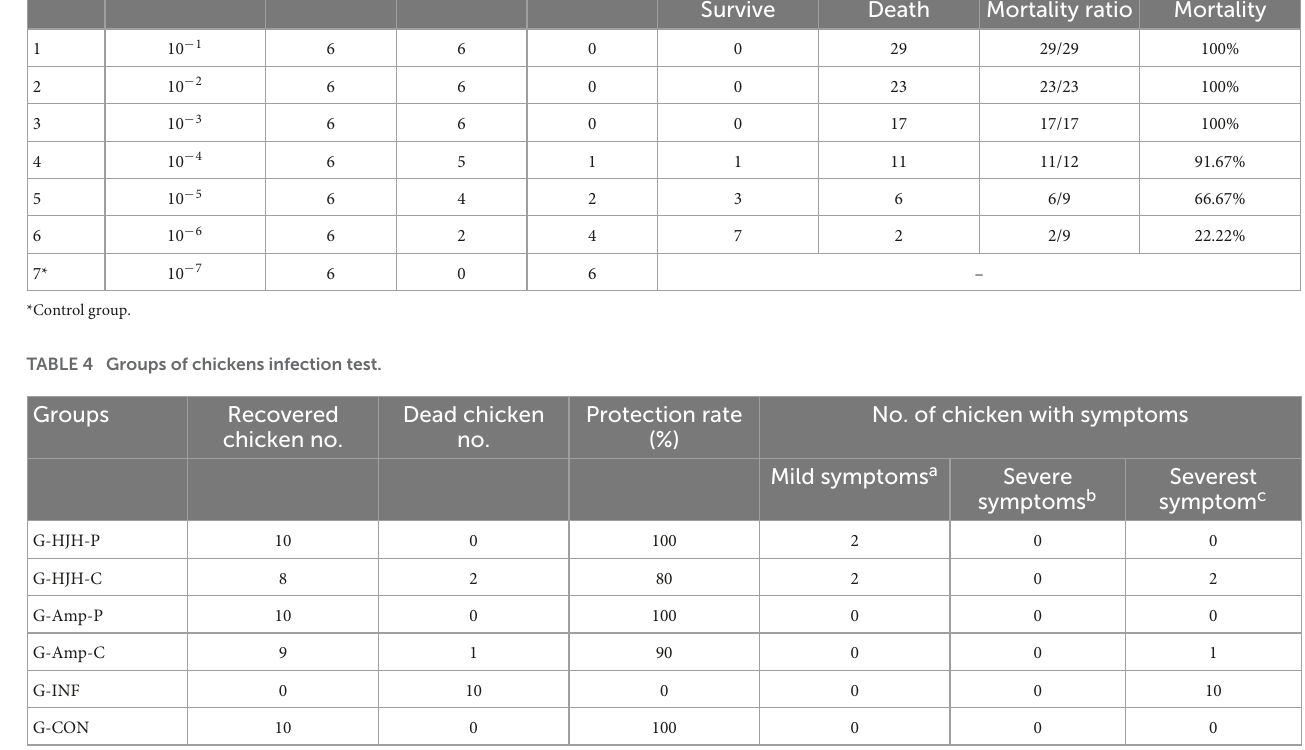
TABLE 3 Determination of LD50 in Chickens by Salmonella Pullorum. Group Bacterial Total no. dilution